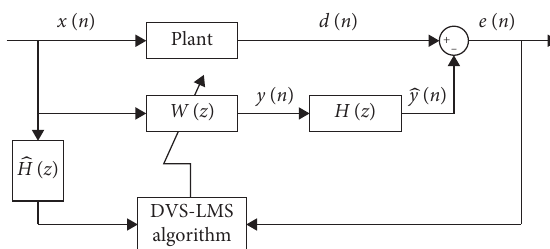
Figure 3: The structural diagram of the DVSFxLMS